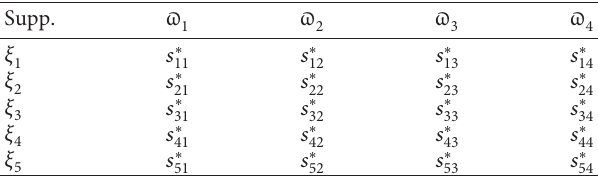
Table 11: Pessimistic aggregated weighted picture hesitant fuzzy decision matrix.